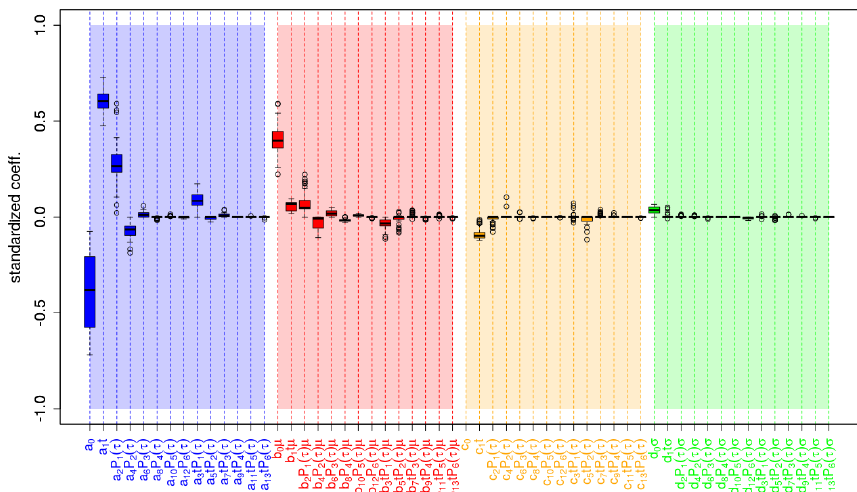
Figure 10. Coefficient estimates for recalibrating global mean 2m temperature of the MiKlip prototype system. Colored boxes represent the interquartile range (IQR) around the median (central, bold and black line) for coefficient estimates from the cross-validation setup; whiskers denote maximum 1.5 IQR. Coefficients are grouped according to correcting unconditional bias (blue), conditional bias (red), unconditional dispersion (orange) and conditional dispersion (green). Values refer to coefficients a 0 ,b 0 ,c 0 ,d 0 ,...,a 6 ,b 6 ,c 6 ,d 6 and not to the product between these coefficients and the corresponding predictors (e.g., a 2 P 1 (τ) refers to a 2 ). Please note that the value of c 0 is around − 2.5, but for a better overview the vertical axis is limited to the values range between − 1 and 1. Vertical dashed bars highlight coefficients related to lead-time-dependent terms.